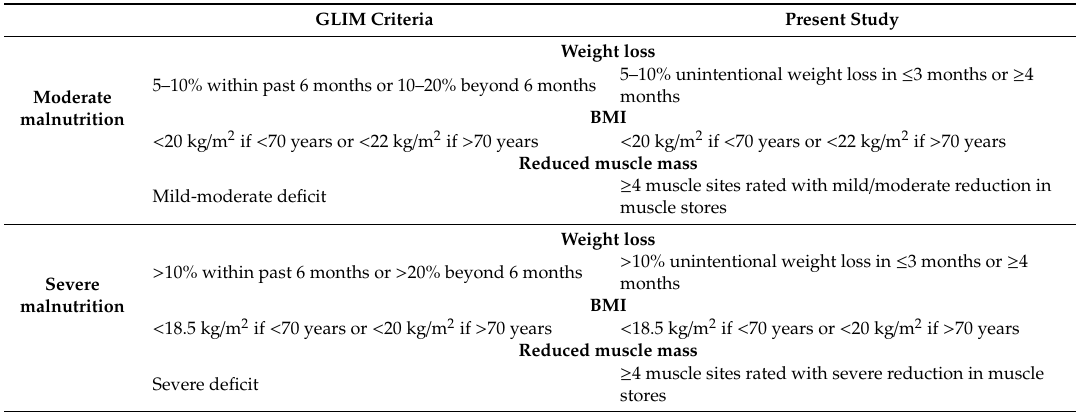
Table 2. How the GLIM criteria severity grading was applied in the present